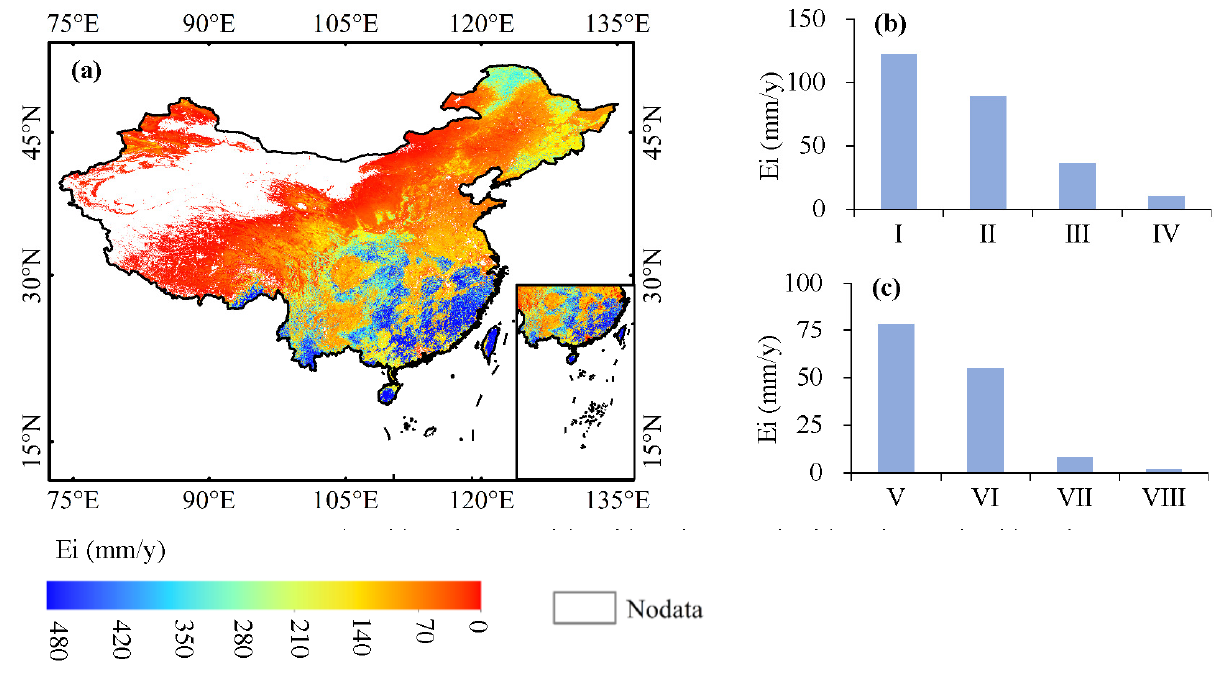
Figure 2. The spatial distribution of Ei across China during 2001–2020. ( a ) The spatial distribution of Ei; ( b ) the average Ei of different thermal regions. I, II, III, and IV are tropical regions, subtropical regions, temperate regions, and plateau climate regions, respectively; ( c ) the average Ei of different moisture regions. V, VI, VII, and VIII are humid regions, semi-humid regions, semi-arid regions, and arid regions, respectively.